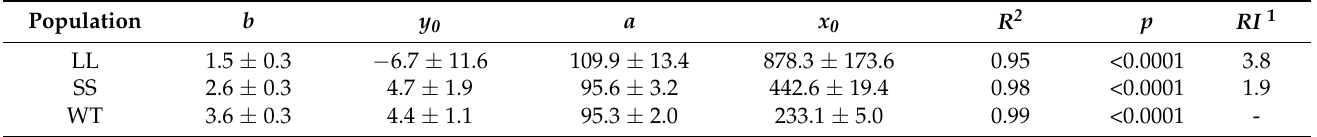
Figure 1. Response of three populations to different doses of glyphosate at 14 days after treatment (DAT). The dose–response curve of these three populations calculated by nonlinear regression analysis, vertical bars represent the standard errors of the means (SEM). Table 1. Parameter estimates (SE) by nonlinear regression for the dose–response assay using fresh shoot weights, and four samples were designed and selected for each